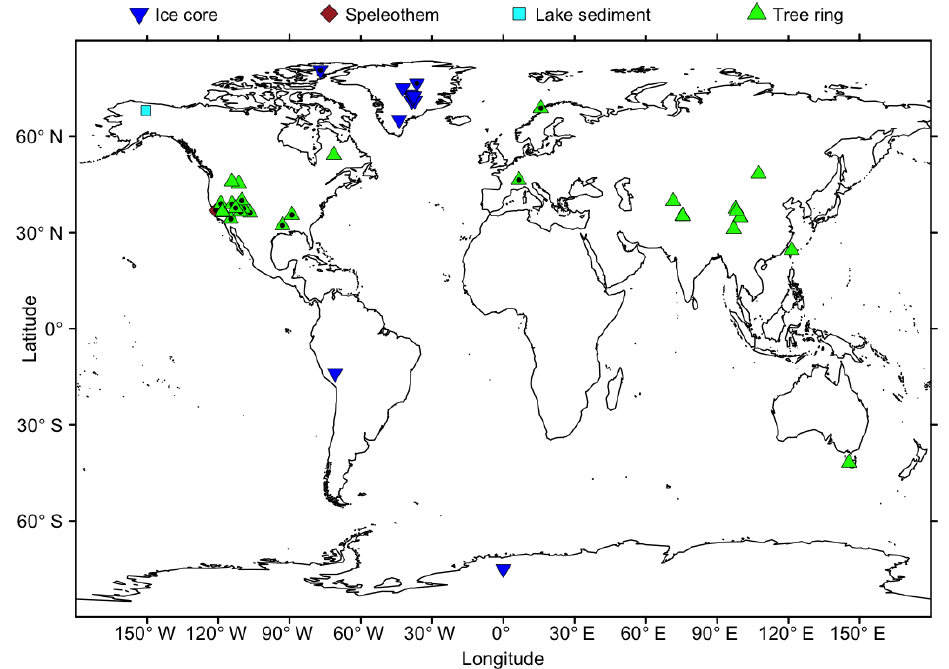
Figure 10. Map of the 46 proxy records used for the reconstruction of the NAO index from Jones et al. (1997) over the time window 1000–1972 using the RF method. Points with a black dot are proxy records also used in Ortega et al. (2015).